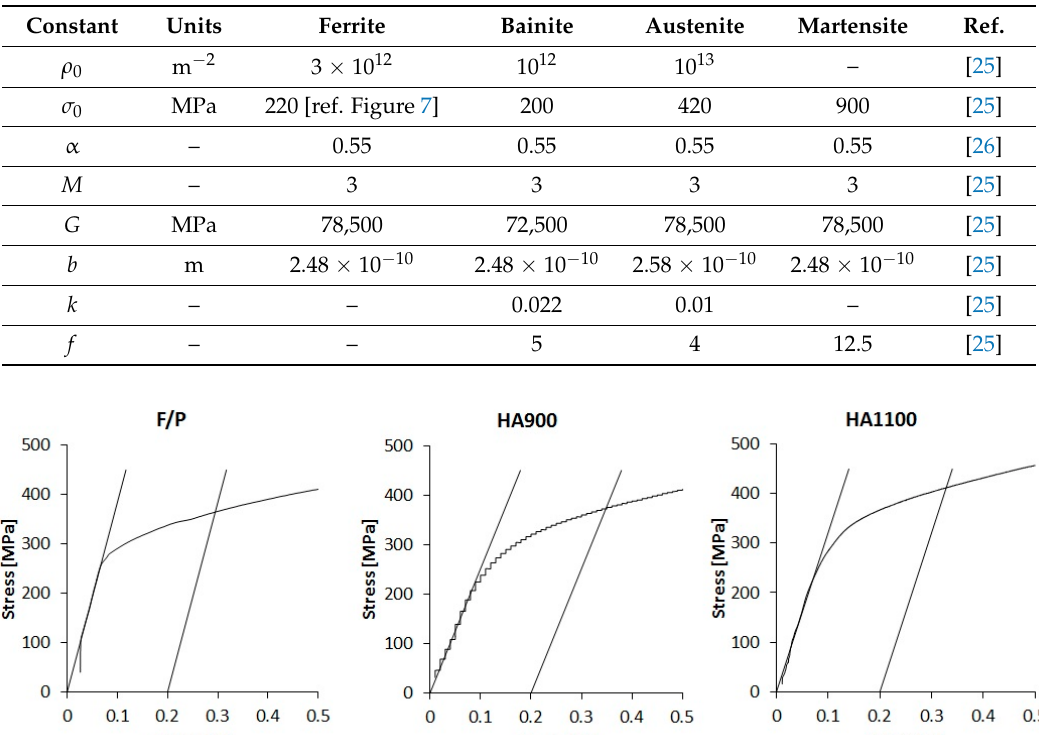
Table 7. Fixed parameter values.